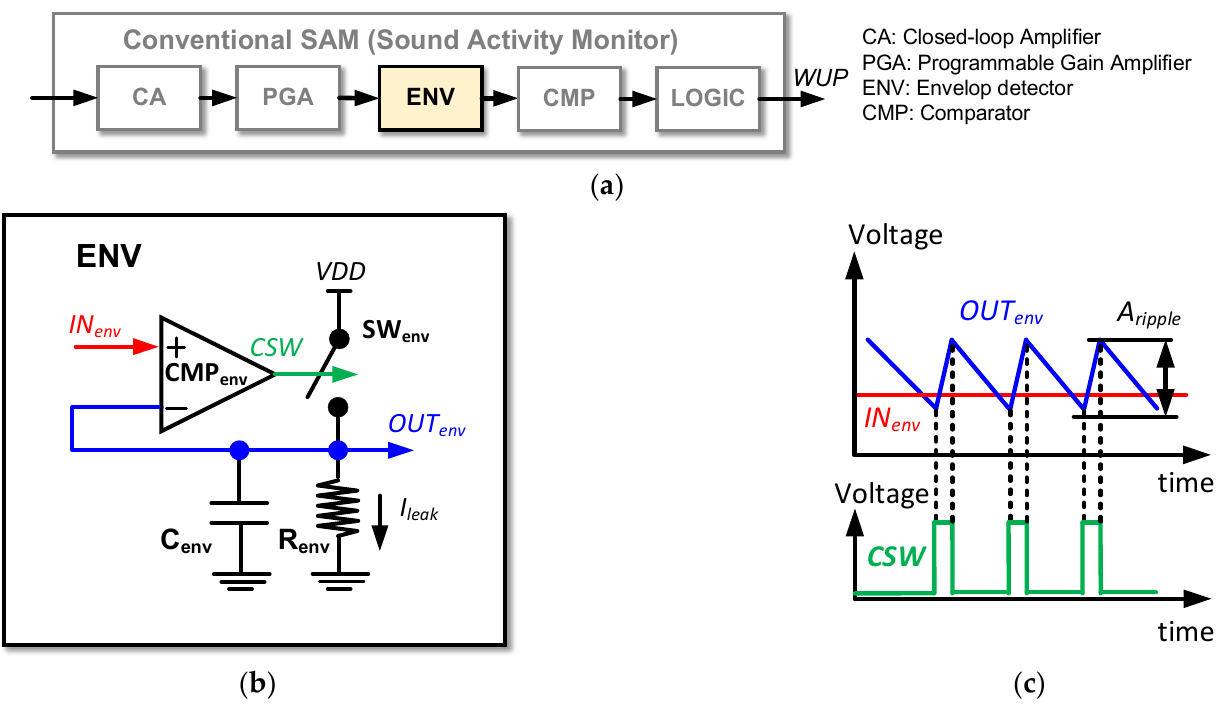
Figure 5. Architecture approach 3: ( a ) A conventional SAM includes a conventional envelope detector (ENV) and a comparator (CMP); ( b ) The configuration of a conventional envelope detection circuit (ENV); ( c ) Signal diagram of a conventional envelope detector.